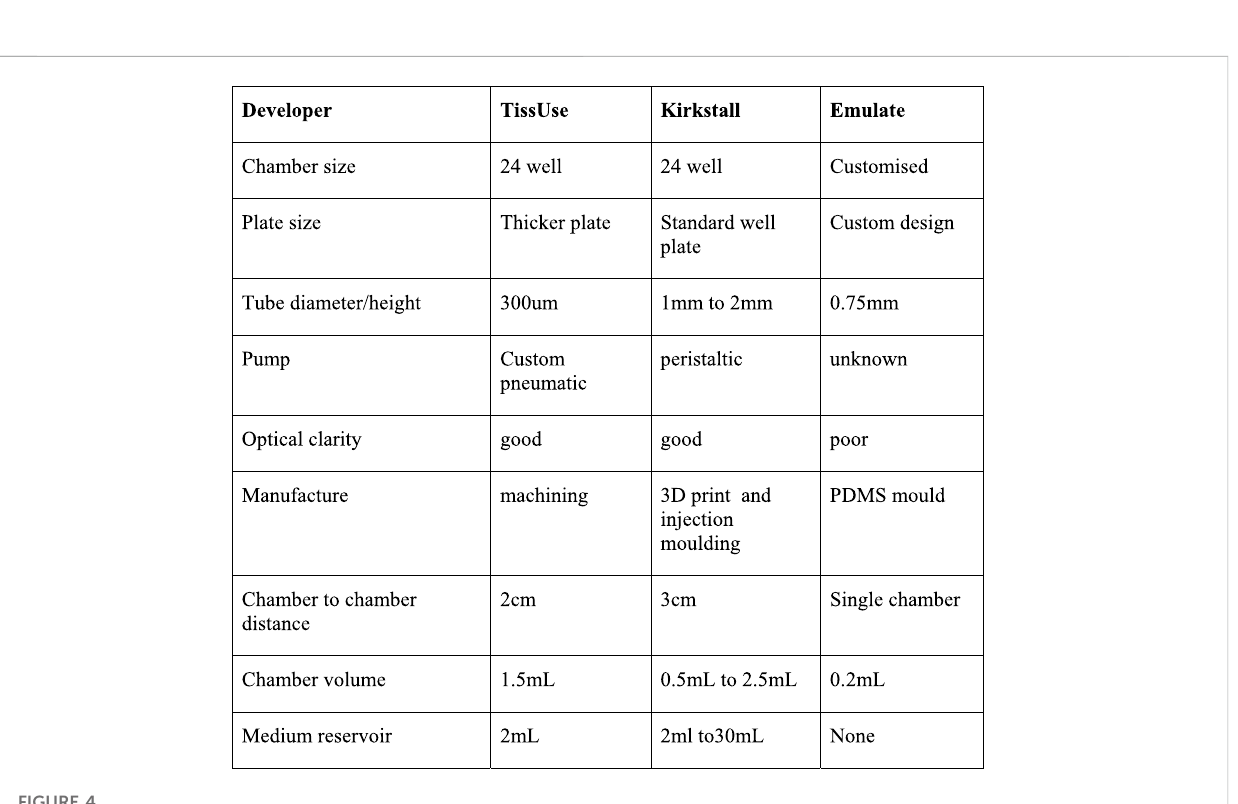
FIGURE 4 Comparison of TissUse GmbH, and Kirkstall Ltd., and Emulate Inc. OOAC